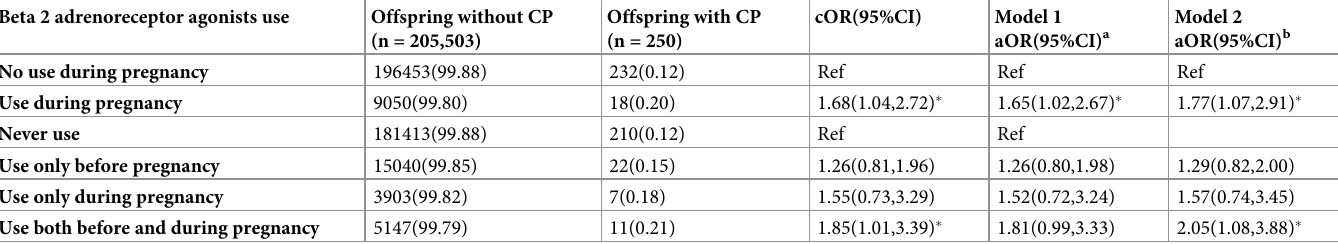
Table 4. Association between maternal β 2AAs usage and cerebral palsy in female offspring born at term. Beta 2 adrenoreceptor agonists